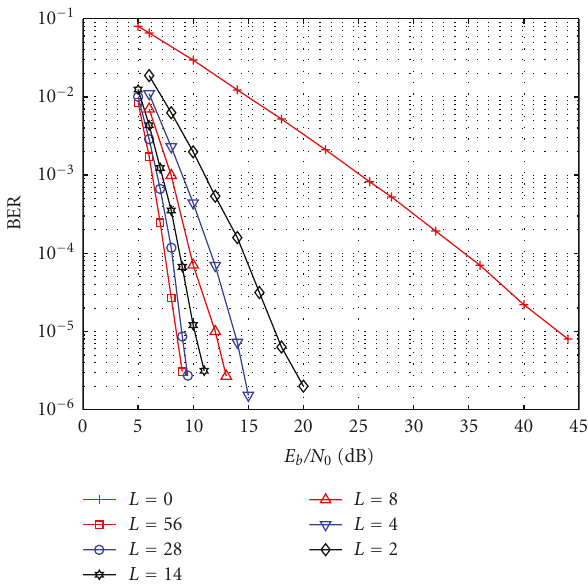
Figure 6: Performance of distributed GLD codes without source- destination path.